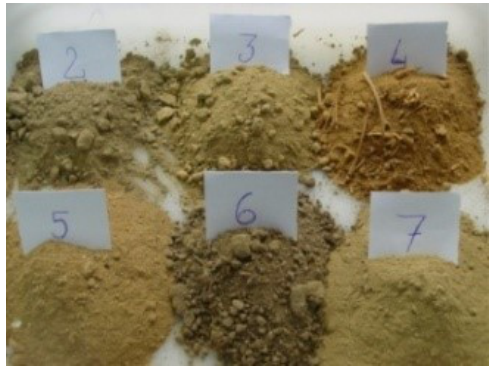
Figure 2: Tabique building studied.